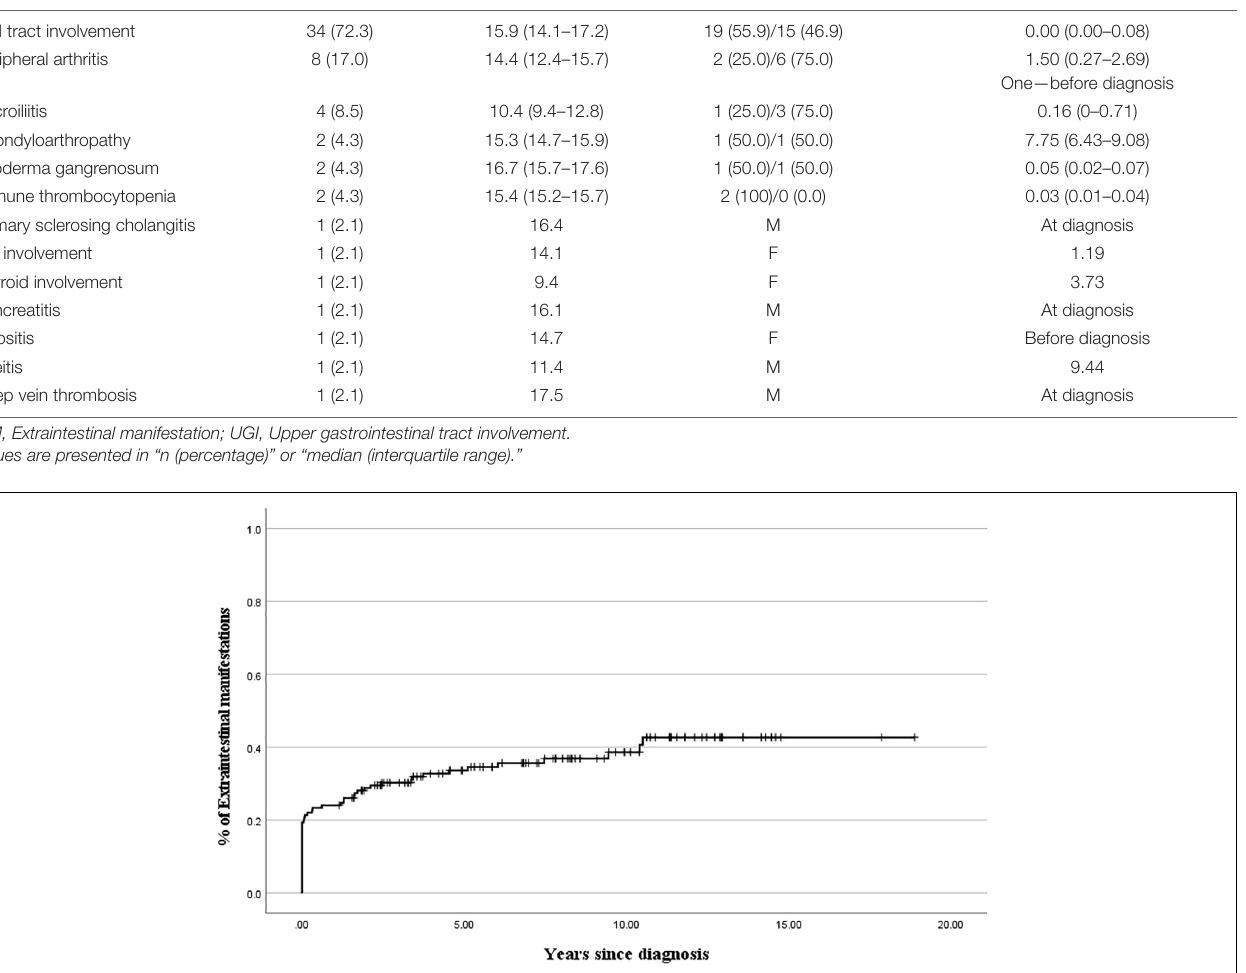
TABLE 1 | Clinical characteristics and the onset time of extraintestinal symptoms of patients in the EIM ( + ) group. Variables Patients